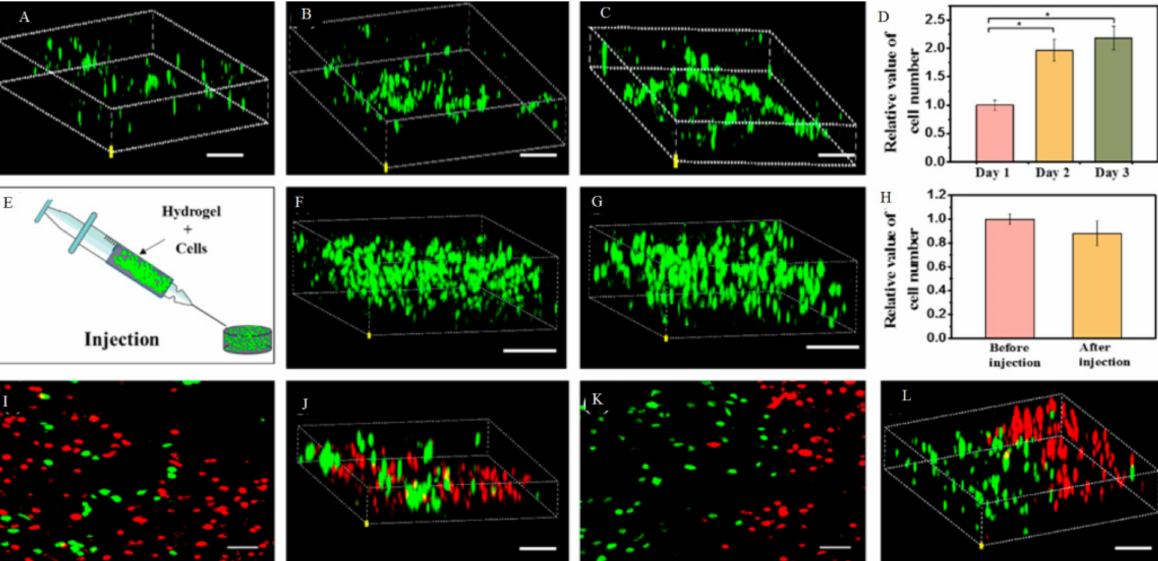
Figure 8. Confocal image of cell proliferation of the C2C12 myoblasts encapsulated in the CS-AT10 hydrogels. ( A ) Visu- alization of cells proliferation during 1 ( B ) 2 and 3 days ( C ). Proliferation curve of the C2C12 myoblasts encapsulated in the hydrogel ( D ). Injection self-healing hydrogels with encapsulation cells ( E ) and visualization cells before ( F ) and after injection ( G ). The diagram indicated conductive hydrogel has the highest live cell numbers in the hydrogel after injection ( H ). Visualization two type of cells encapsulated injection hydrogel ( I – L ). Reused permission with from [79] Copyright © 2021 American Chemical